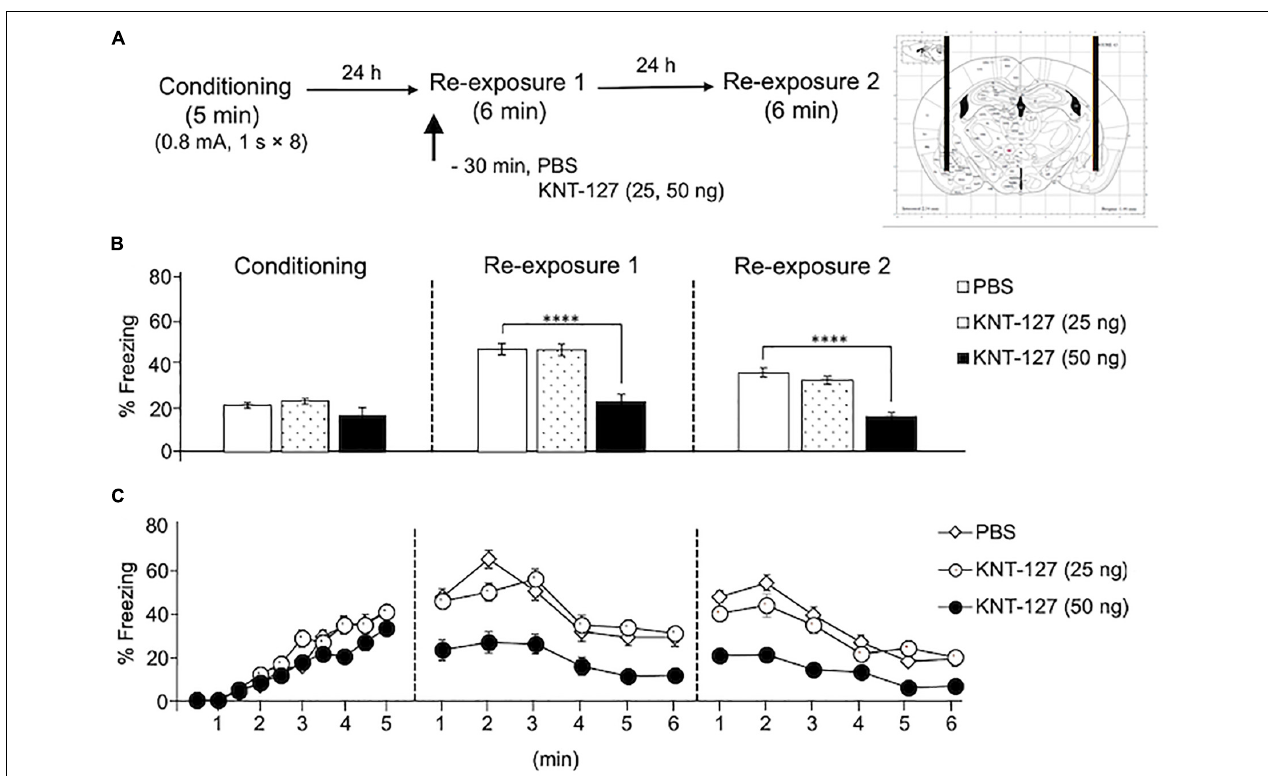
FIGURE 1 | Intra-BLA administration of KNT-127 significantly reduced the contextual fear memory. (A) Experimental design. Mice were bilaterally administered with PBS ( n = 16) or KNT-127 ( n = 11 for 25 ng, n = 13 for 50 ng) into the BLA 30 min before reexposure 1 (6 min). Twenty-four hours after reexposure 1, a fear memory was tested in the same context for 6 min (reexposure 2). (B) Freezing rates of mice during conditioning, reexposure 1, and reexposure 2. KNT-127 significantly reduced freezing rates during reexposures 1 and 2. (C) Time course of the freezing rates of mice during conditioning, reexposures 1 and 2. Data were expressed as mean ± SEM. **** p < 0.0001 for comparisons between PBS group by one-way or two-way ANOVA and post hoc Bonferroni’s